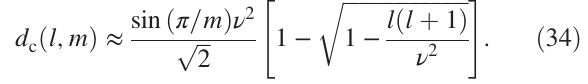
FIG. 10. Density of states for a μ ¼ 30 SQD composite as a function of lattice spacing d in atomic units. The oscillator frequency is set to ω ¼ 1 and the color is the same as in Fig.